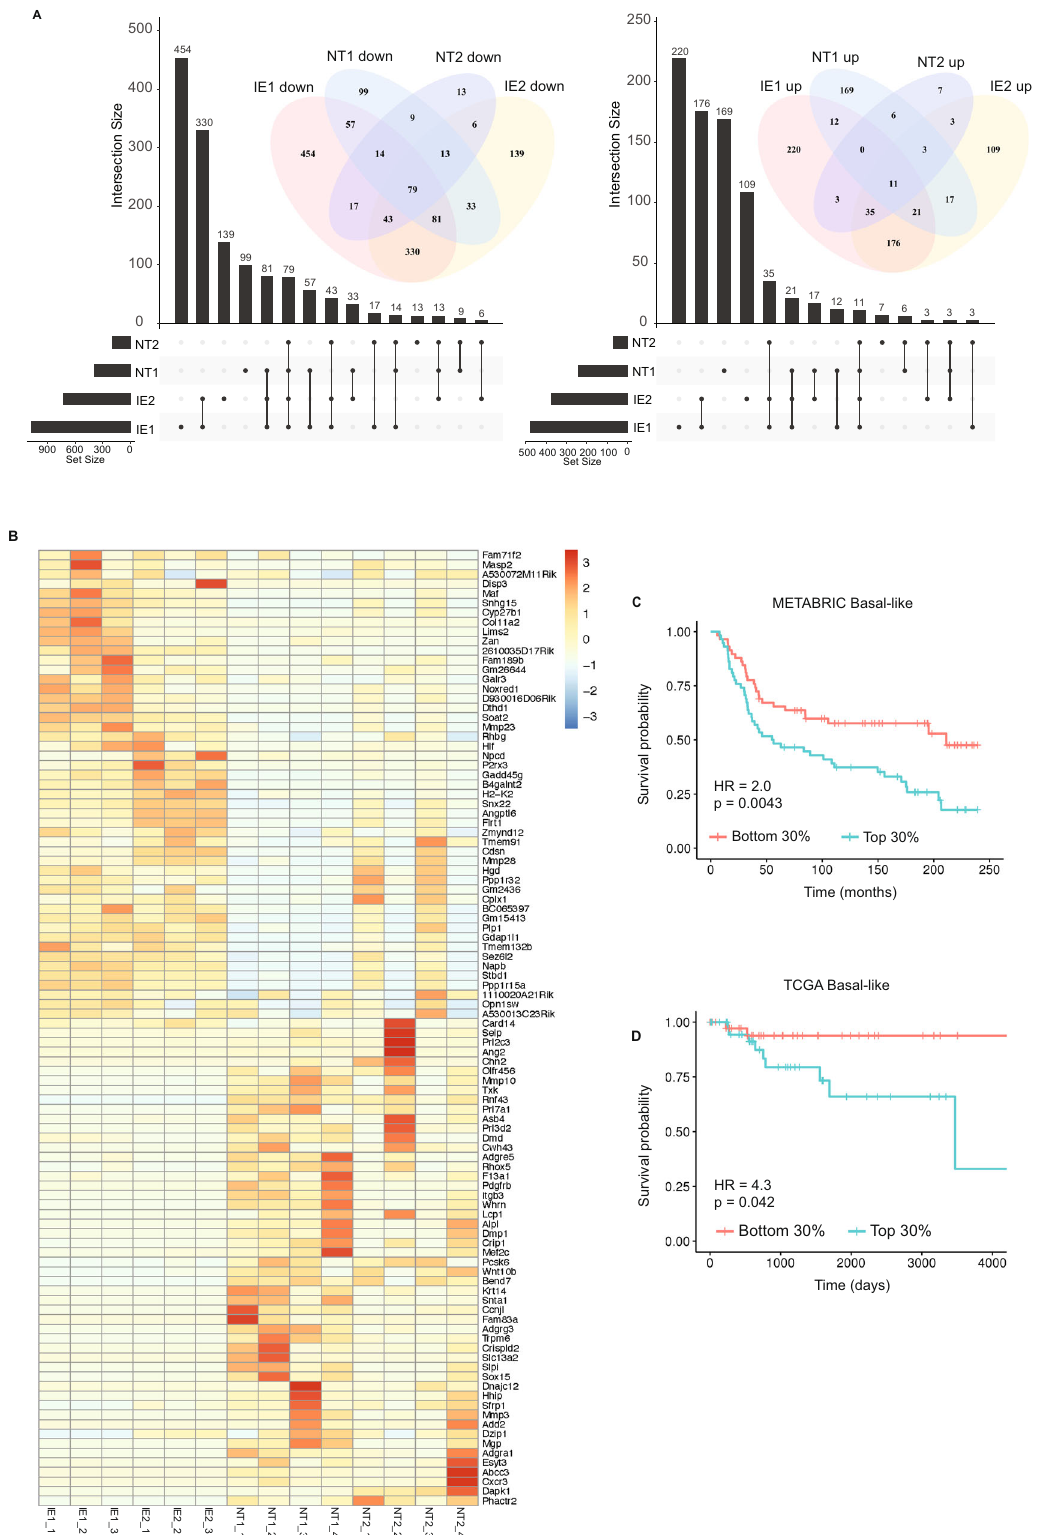
Fig. 7 | Overlapping gene signatures of the immunotherapy-resistant clones show prognostic signi fi cance in basal-like breast cancer patients. A Upset plots and Venndiagramsshowtheoverlapinsigni fi cantlyupregulated(right)anddownregulated(left)genesbetweenthetwoimmunotherapy-enrichedclones(IE1andIE2)andtwo control clones (NT1 and NT2). B Heatmap of the top 50 overlapping upregulated and downregulated genes between IE1 and IE2 clones across all clonal cell lines. C Kaplan – Meier analysis of overall survival of basal-like breast cancer patients in the METABRIC cohort based on whose breast cancer having the top 30% ( n =58) or the bottom 30% ( n =58) expression of the overlapping upregulated 25 gene signature. 116 patients total, with 58 per group. D . Kaplan – Meier analysis of overall survival of basal-like breast cancer patients in the TCGA cohort based on whose tumour having the top 30% ( n =40) or the bottom 30% ( n =40) expression of the overlapping upregulated 25 gene signature. Eighty patients total, with 40 per group. In C , D , the Cox proportional hazards model was used to compute hazard ratios. Signi fi cance between strati fi cation groups were computed using log-rank test